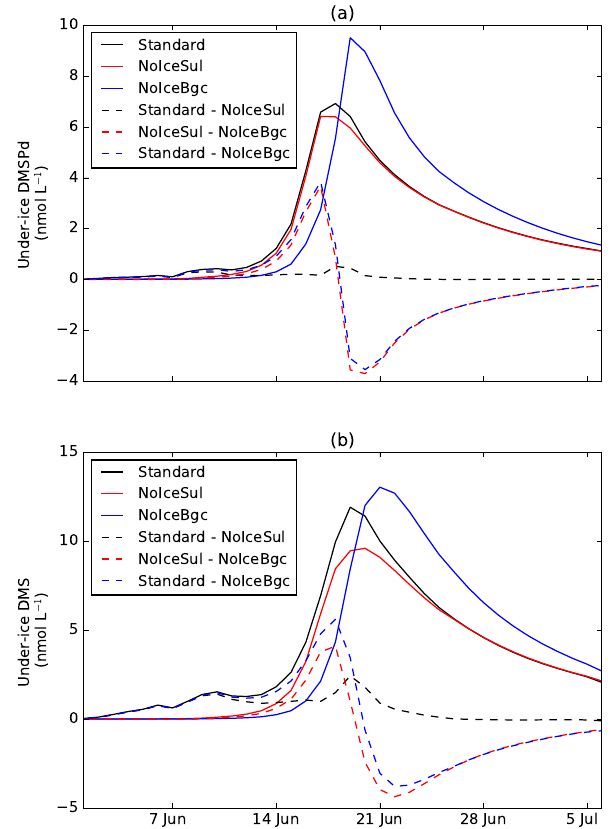
Figure 5. Simulated time series of (a) DMSPd and (b) DMS con- centrations (nmolL − 1 ) in the uppermost layer (0.5m below the ice) of the water column during the melt period in 2010 for the standard run (Standard) and the sensitivity runs that excluded the sea-ice sul- fur cycle (NoIceSul) and both the sea-ice sulfur cycle and ecosys- tem (NoIceBgc). Dashed lines represent the concentration differ- ence between the two runs of interest. Positive differences represent enhancement in the concentration due to the incorporation of sea-ice sulfur cycle (Standard – NoIceSul), sea-ice ecosystem (NoIceBgc – NoIceSul), and both sea-ice sulfur cycle and ecosystem (Standard – NoIceBgc), respectively, while negative values represent